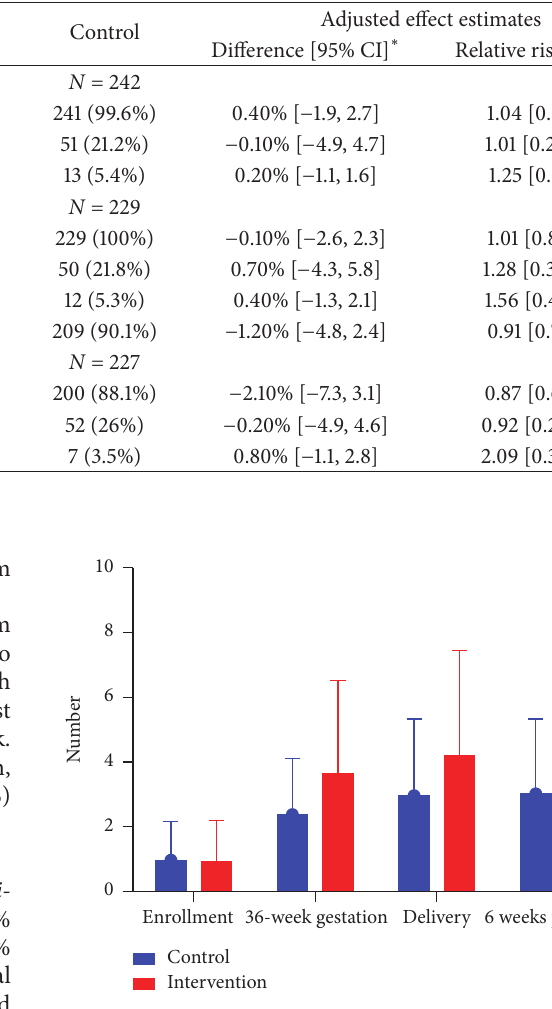
Figure 2: Frequency of communication from enrollment until 6 weeks postpartum. Depicting the mean frequency and standard deviation of communication between women and health care workers as reported by women at enrollment, between enrollment and 36 weeks of gestation, between 36 weeks of gestation and within 7 days of delivery, and between the delivery visit and 6–8 weeks